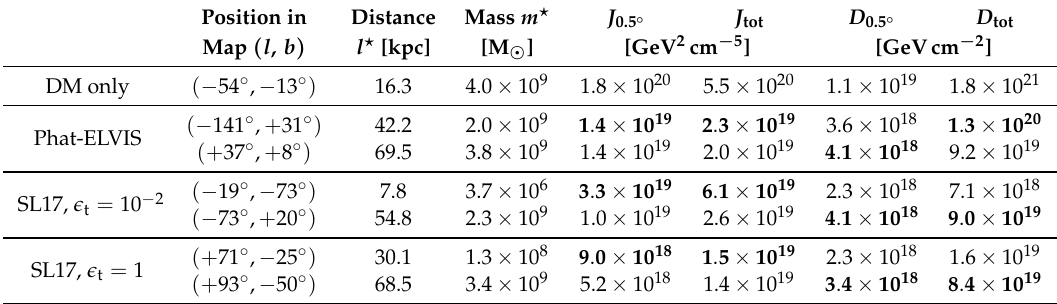
Table A1. Properties of the brightest subhalos in the random realizations displayed in Figure 4. Position in